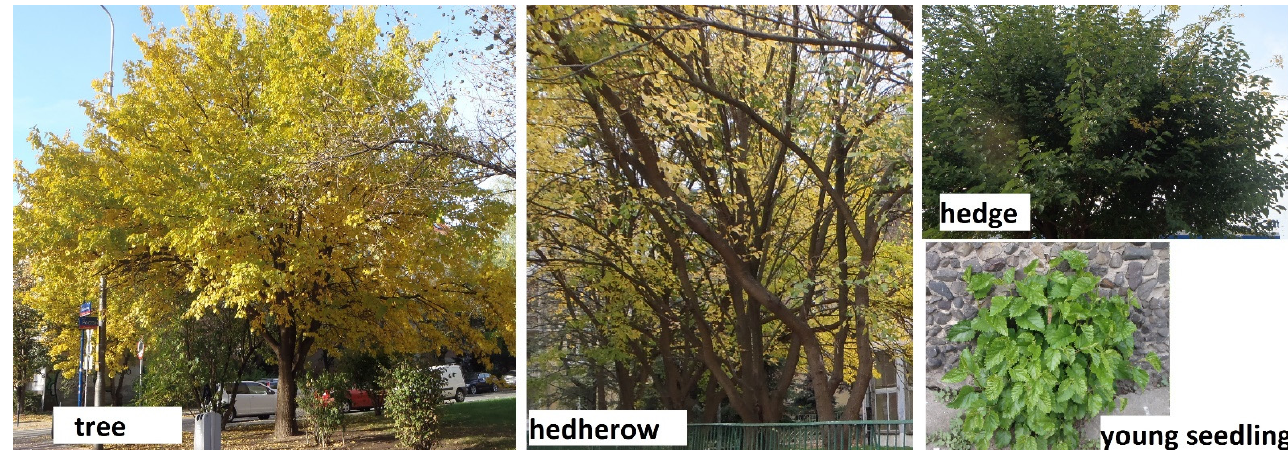
Figure 3. Mulberry growth types.